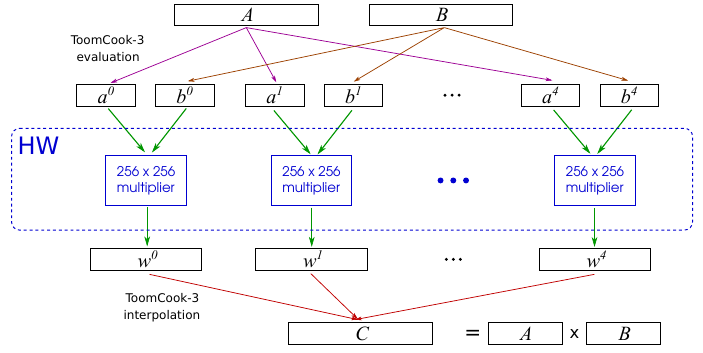
Figure 2: Proposed HW/SW partition for a Florete